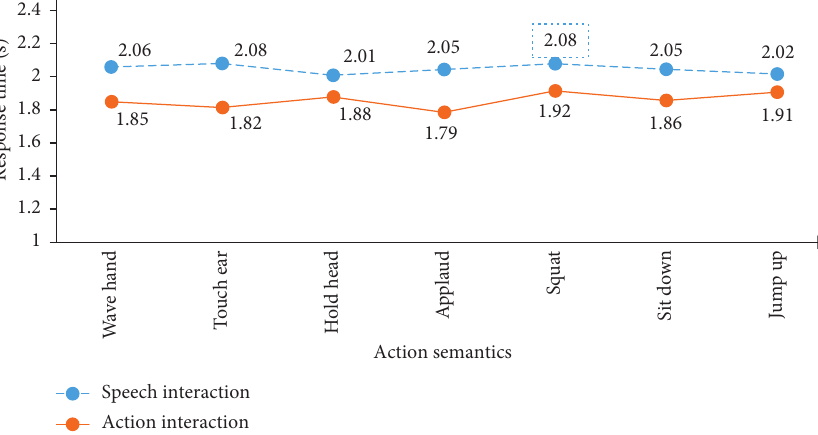
Figure 10: Comparison of the response time of speech and action